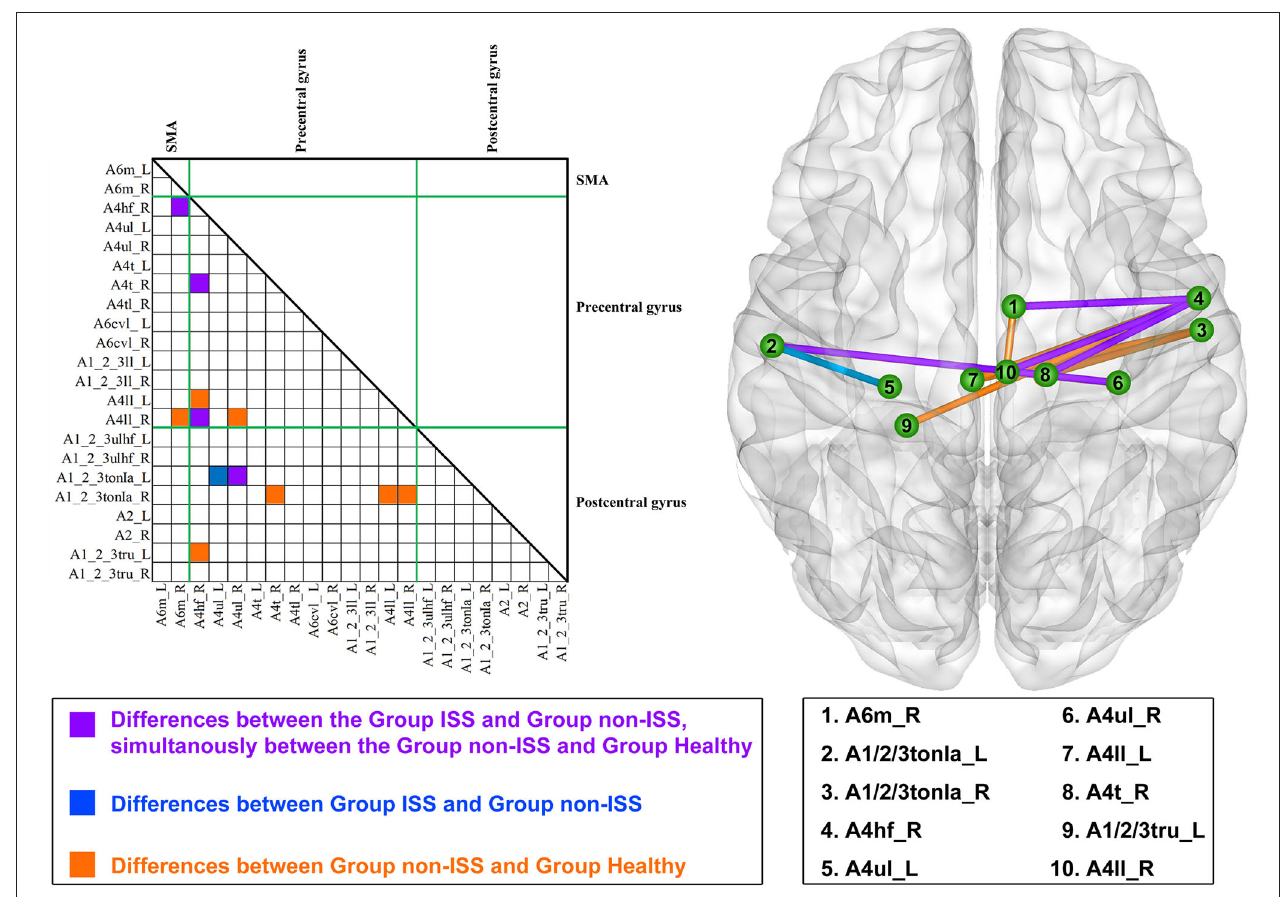
FIGURE 1 | Alterations in functional connectivity (FC) among the ISS, non-ISS, and healthy groups. ISS, group of patients with intraoperative stimulation-induced seizures; Non-ISS, group of patients without intraoperative stimulation-induced seizures. insignificantly altered in the ISS group after FDR correction.